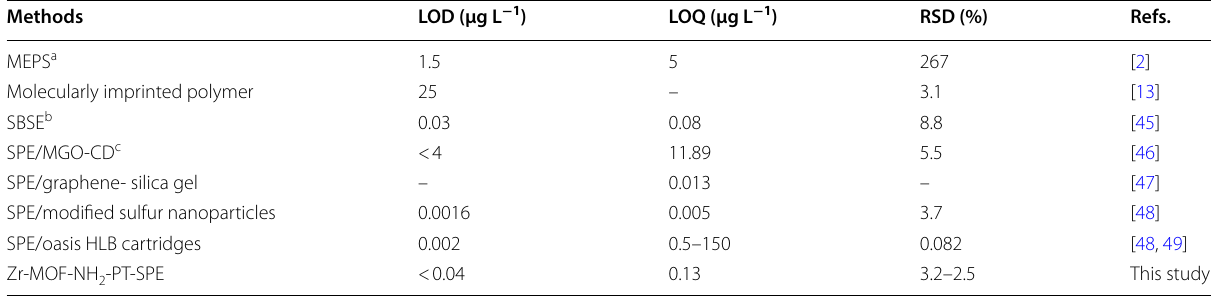
Table 3 Comparisons of the proposed methods with other methods for extraction of